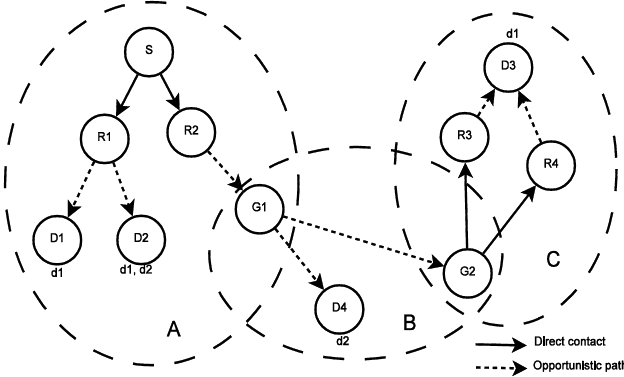
Figure 6. The MDM data forwarding process [34].